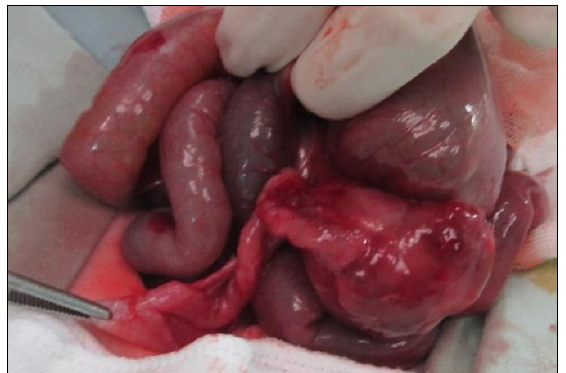
Figure 1: Calcified mass originating from the ileum wall, measuring 4 cm long axis and located at 10cm proximal to the Ileocoecal